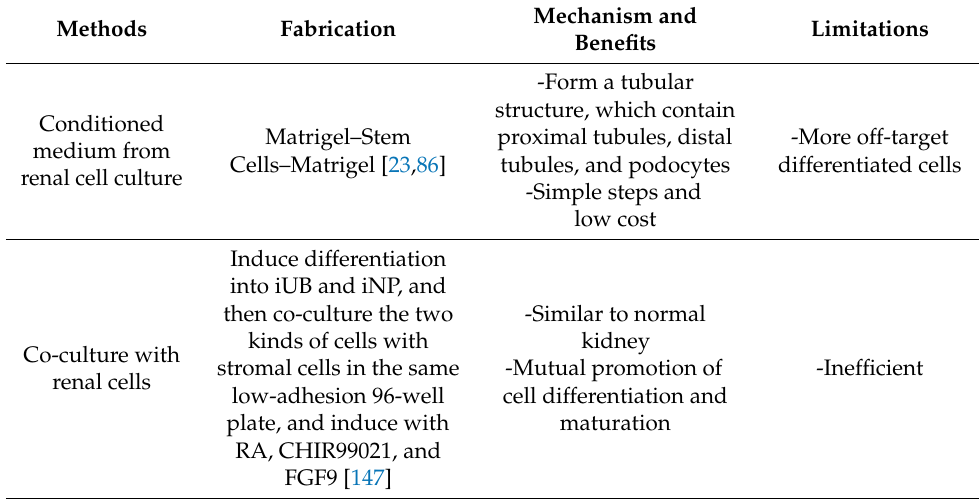
Table 5. Methods used to induce reno-differentiation of stem